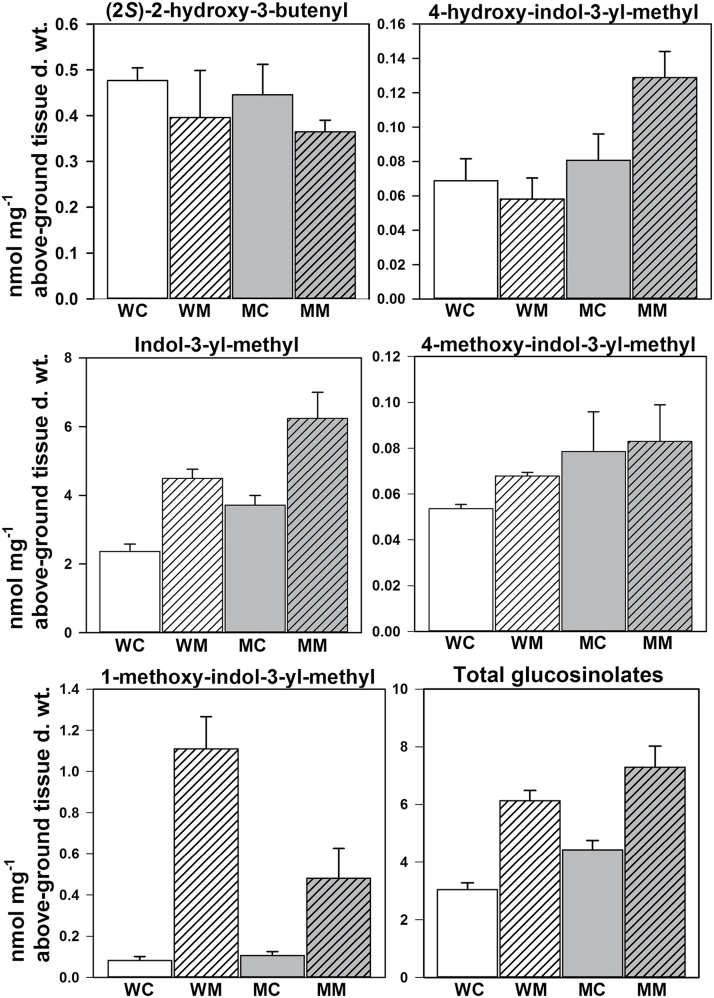
Glucosinolate levels in control and M. brassicae challenged seedlings (n = 4). WC, wild-type control; MC, MINELESS control; WM, wild-type M. brassicae; MM, MINELESS M. brassicae. Error bars represent SE. No significant differences were found after post hoc Bonferroni corrections (P < 0.00833).